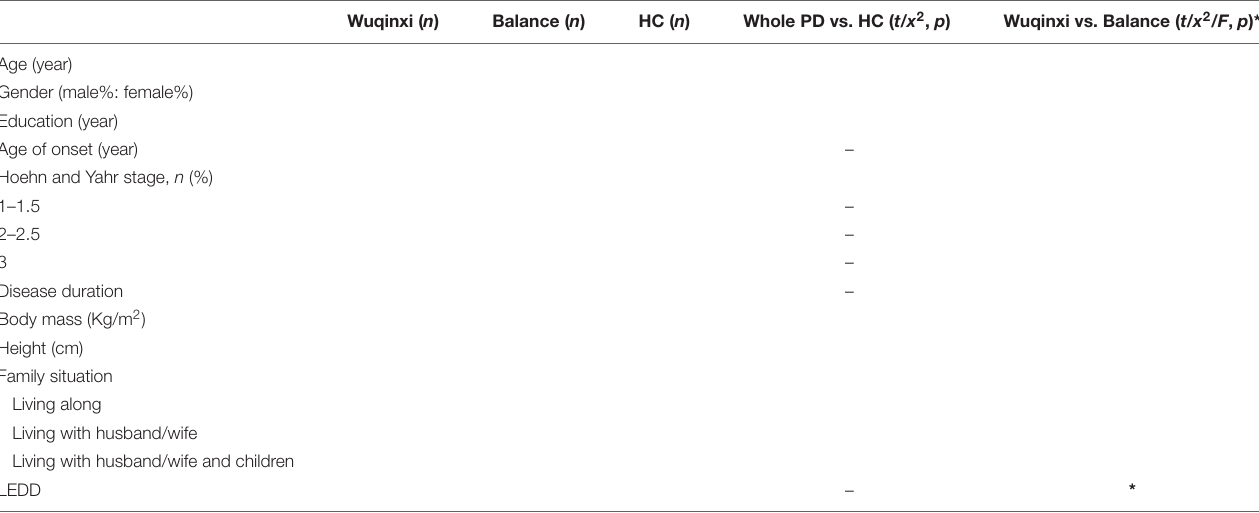
TABLE 1 | Demographic characteristics.